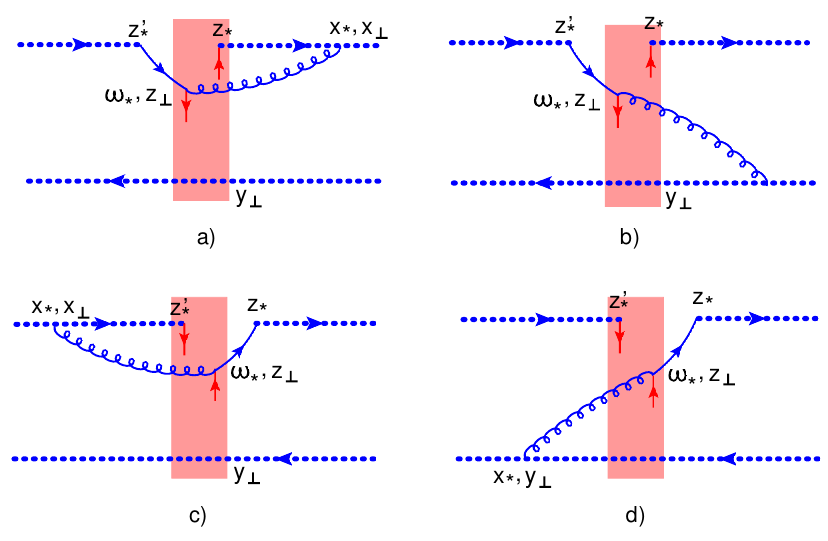
ˆ˜ ˆ˜ Q 1 ( x ⊥ ) and Q 5 ( x ⊥ )